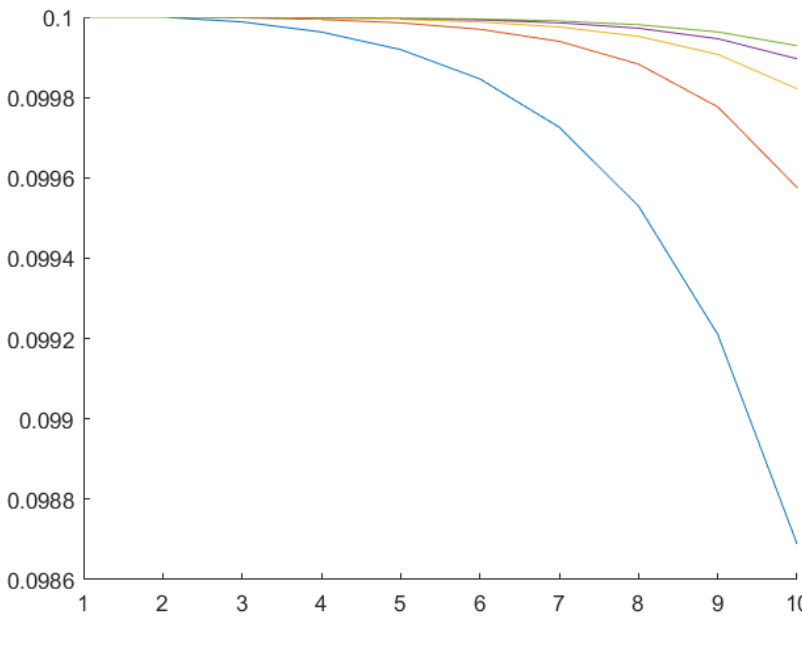
Figure 6. “Feather” angles β change under the multiagent control law